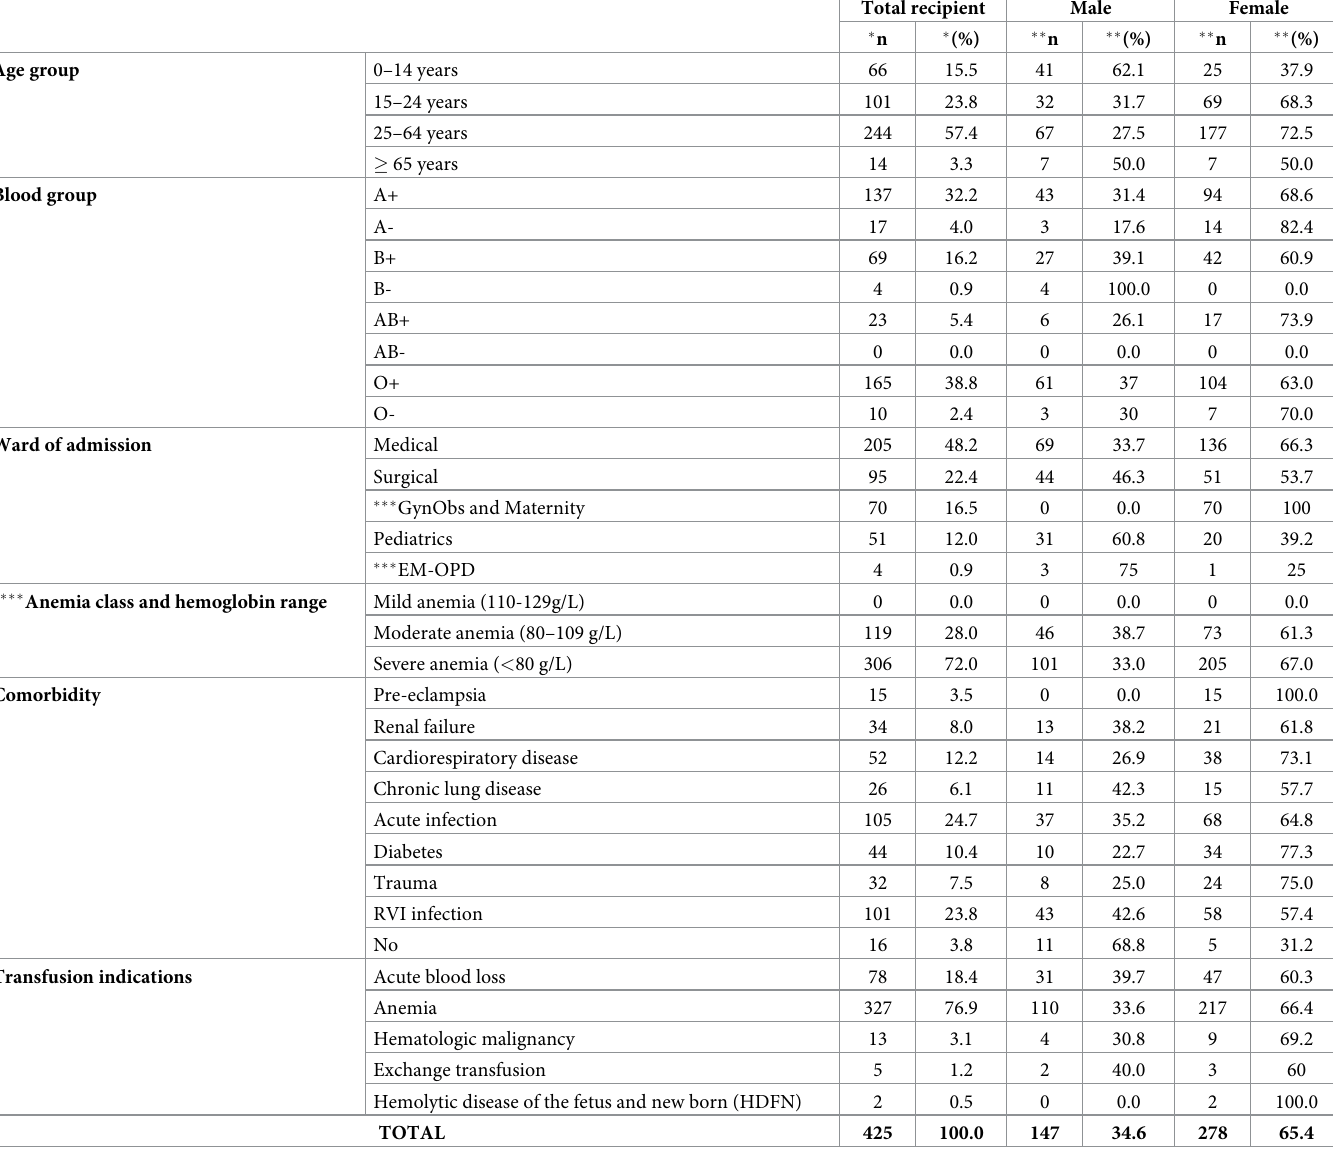
Table 1. Demographic and clinical data of blood transfusion recipients according to their sex at JMC, southwest Ethiopia, February 1 to June 30, 2018 (n =